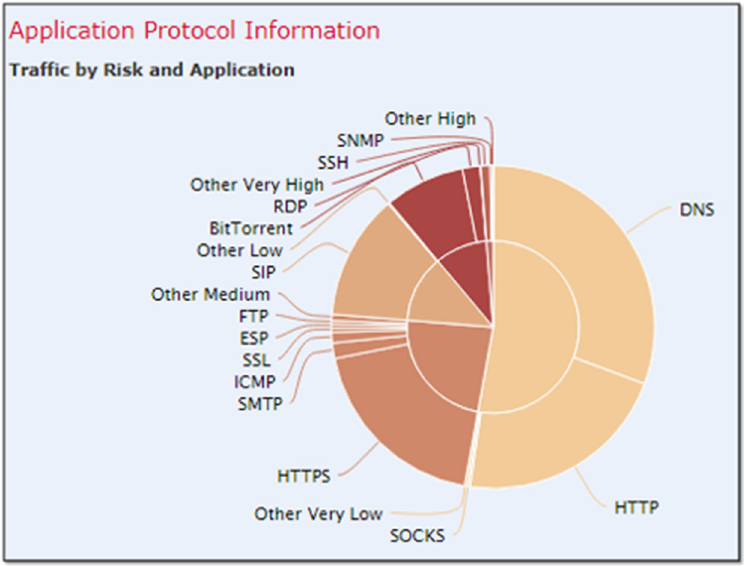
Figure 10. Application Protocol Information: Traffic by Risk and Application extracted from Fire- power.